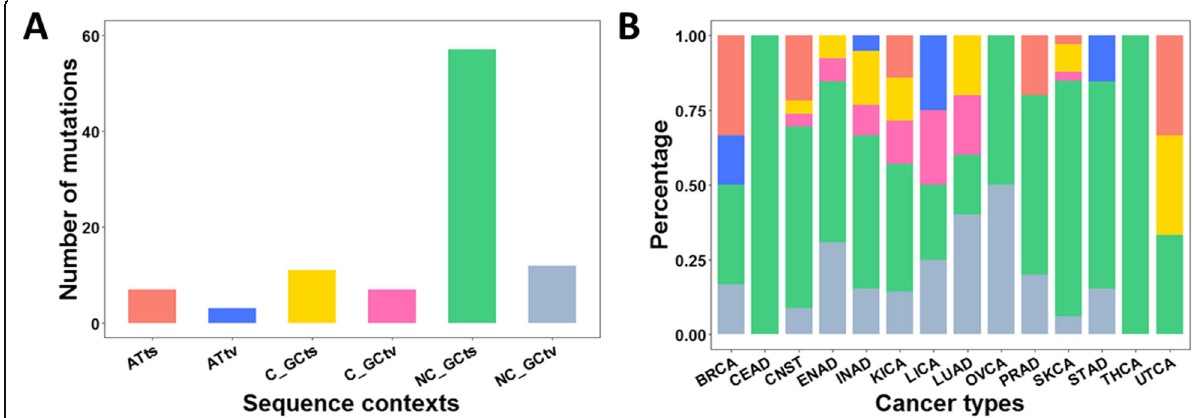
Fig. 4 Mutational signatures of synonymous hotspot mutation in 15 cancer typers. a Histogram of the number of hotspot mutations under different sequence contexts. b Bar diagram where the value 100% represents the total number of mutations under different sequence contexts distributed in each cancer type. ATts, AT transition (coral bar in a and b ); ATtv, AT transversion (blue bar in a and b ); C_GCts, CpG-island GC transition (yellow bar in a and b ); C_GCtv, CpG-island GC transversion (rose bar in a and b ); NC_GCts, non-CpG-island GC transition (green bar in a and b ); NC_GCtv, non-CpG-island GC transversion (grey bar in a and b